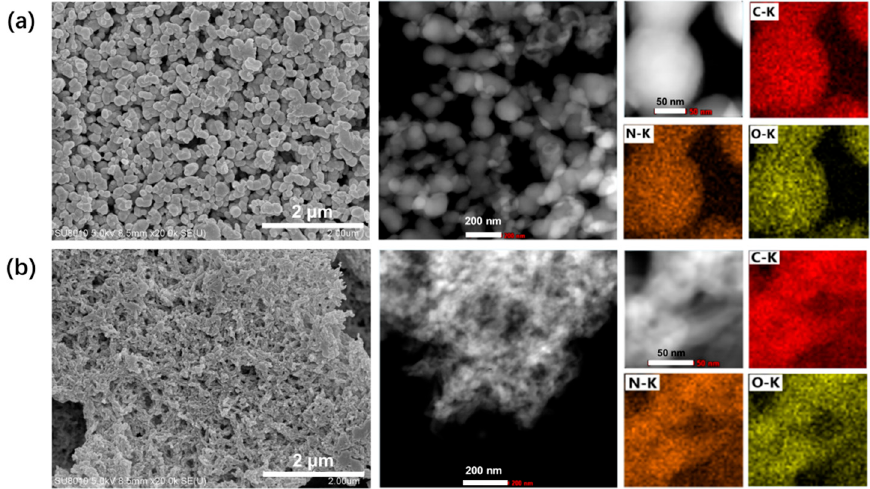
Figure 1. SEM, TEM and EDS-mapping of ( a ) TpPa − SO 3 H and ( b ) TpPa − Py.